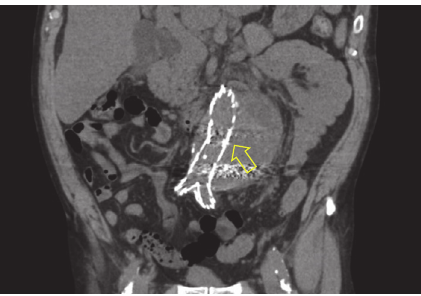
Figure 1: CT abdomen showing an expanding abdominal aortic aneurysm with few gas bubbles around prior endovascular graft